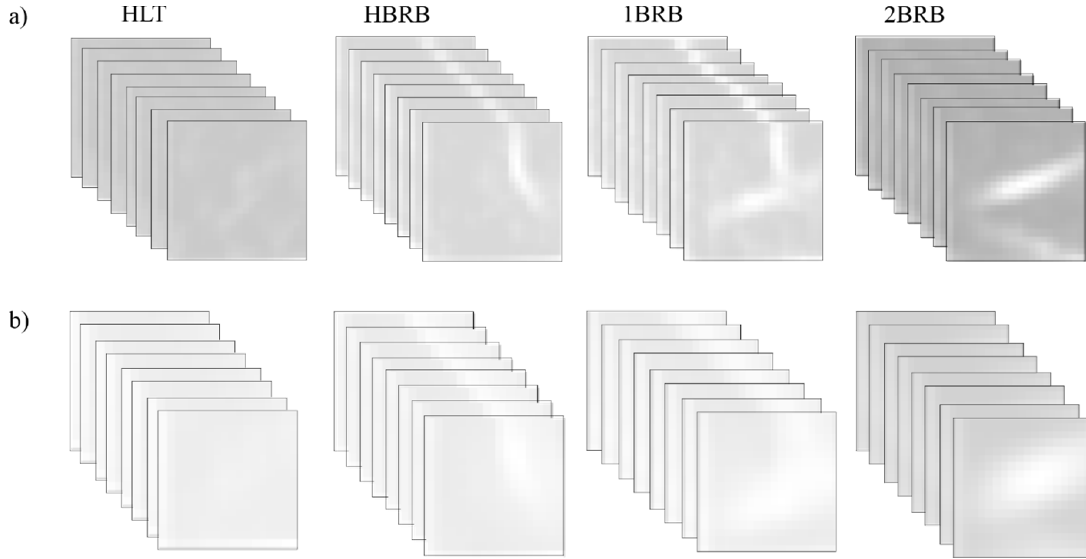
Figure 16. Feature maps for: ( a ) the first convolutional layer; and ( b ) the second convolutional layer.